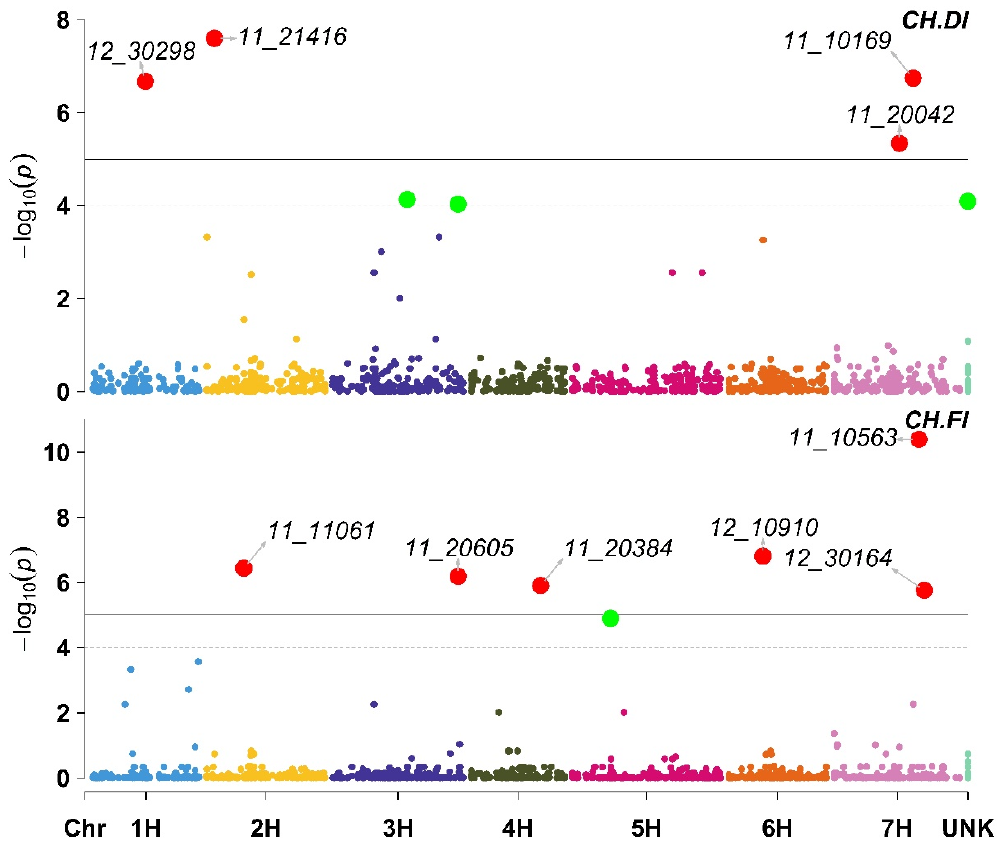
Figure 3. Manhattan plot displaying the results of the genome-wide association scan (red dots annotated dots refer to significant markers or markers with − log10 (p) more than 5, while the green dots refer to non-significant markers but have −log10 (p) between 4 and 5) for the total Chlorophyll Content (CH) using 426 barley lines under Deficit Irrigation (CH.DI, upper plot) and Full Irrigation (CH.FI, lower plot).